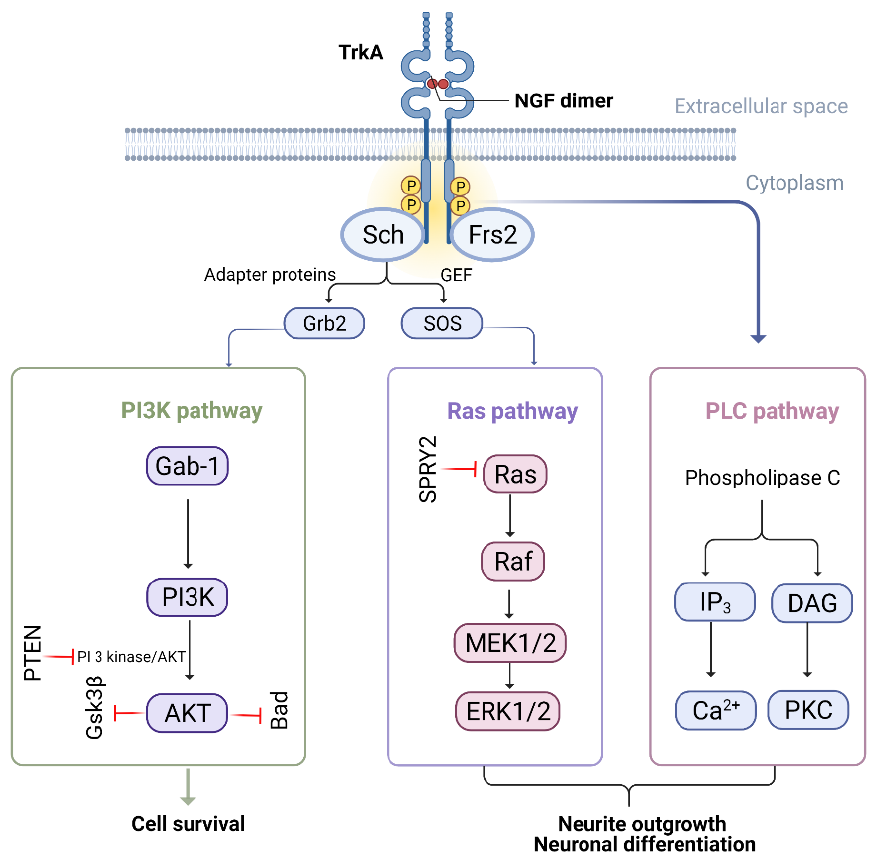
Figure 4. NGF-mediated pathways. Following NGF binding to tropomyosin, receptor kinase activates Ras/ERK and PI3K/AKT, which subsequently leads to increase neuronal survival and, ultimately, axonal growth. TrkA: tyrosine kinase receptor; NGF: nerve growth factor; GEF: guanine nucleotide exchange factor; SOS/Grb2: adaptor proteins; Frs2: fibroblast growth factor receptor substrate 2; ERK: extracellular signal-regulated kinase; PI3K: phosphatidylinositol-3-kinase; AKT: protein kinase B; DAG: diacyl glycerol; PKC: protein kinase C; IP3: inositol triphosphate; Ras/Raf/MEK: protein kinases; Gab-1: GRB2-associated-binding protein 1.